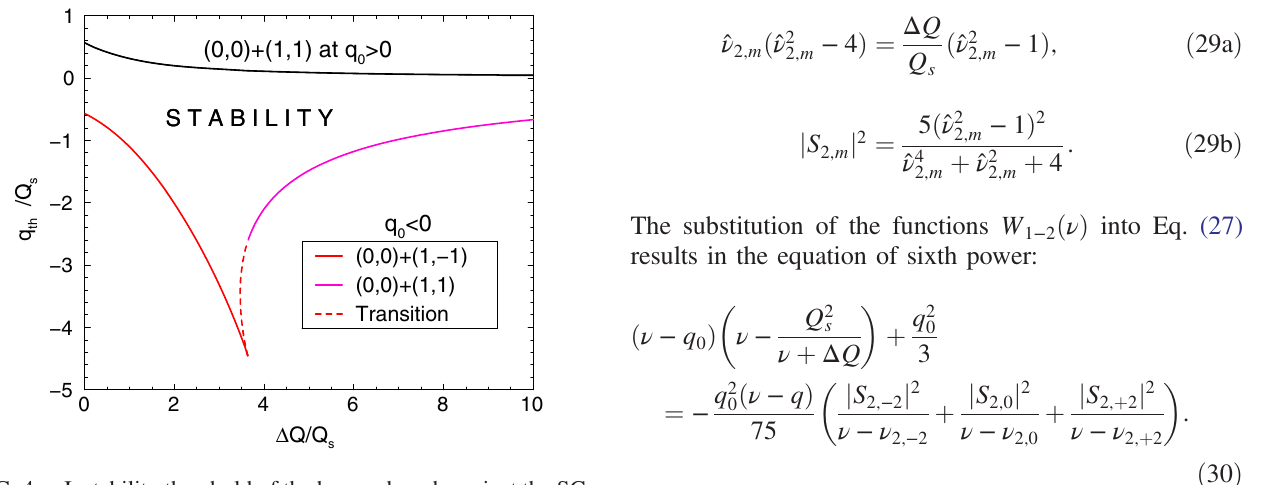
FIG. 4. Instability threshold of the boxcar bunch against the SC tune shift (positive and negative wakes). Indexes of the coalesced modes are shown for each part of the threshold line.